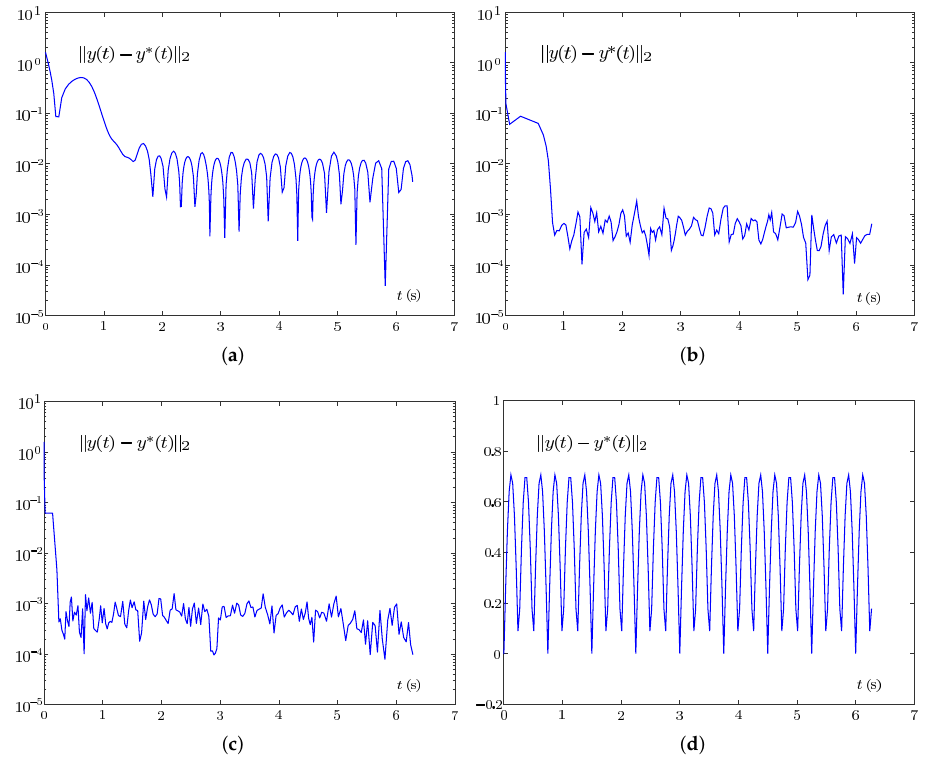
Figure 11. Dynamic characteristics of the (cid:107) y ( t ) − y ∗ ( t ) (cid:107) 2 by the two FPDP models, VPDP model and the pseudo-inverse method with noise η l ( t ) = sin ( 4 π t + π ) . ( a ) FPDP model with AF (5). ( b ) FPDP model with AF (10). ( c ) VPDP model with AF (12). ( d ) The pseudo-inverse